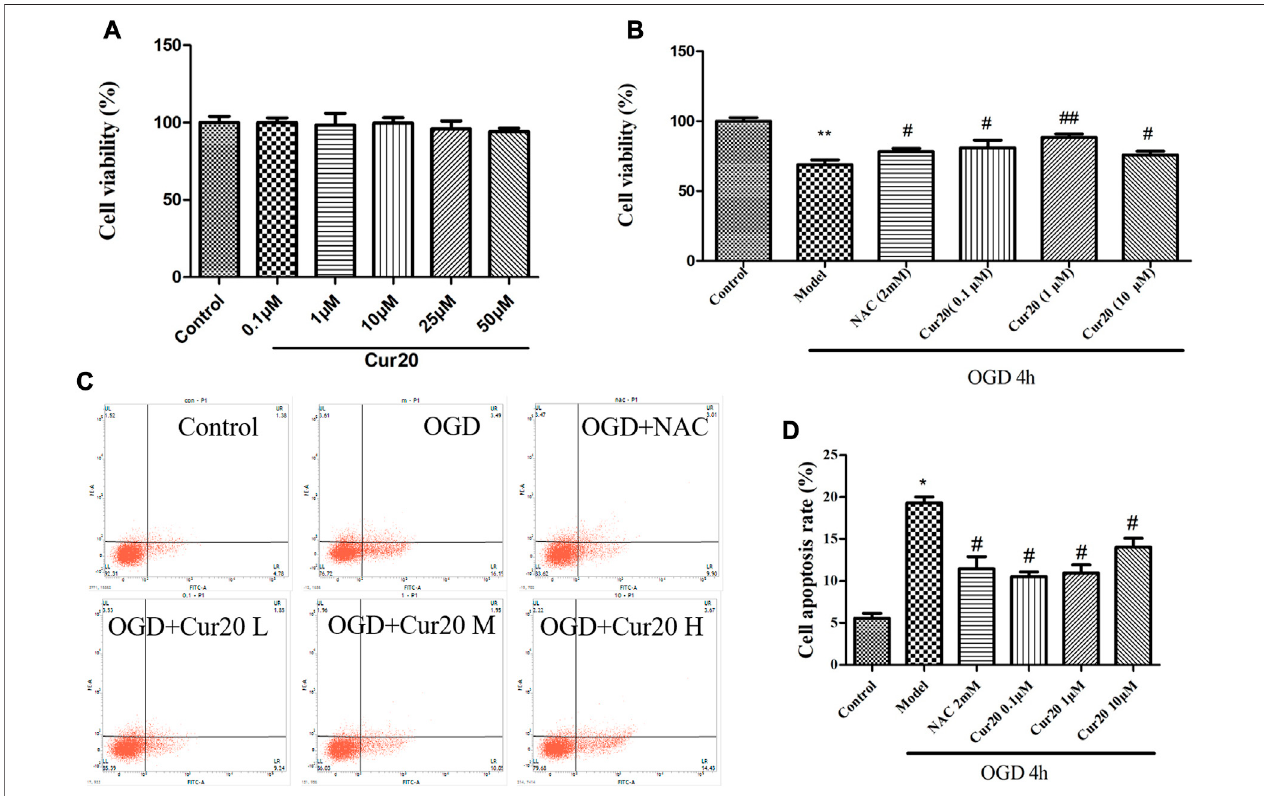
FIGURE7| Cur20showedprotectiveeffectonOGD-treatedrBMECswithoutcytotoxicity. A ,Cur20treatmentperseshowednocytotoxicityonrBMECs. B ,Cur20 reversed OGD-induced cell damage by MTT assay. C – D , Flow Cytometry assay was utilized for cell apoptosis test. L, M, or H represents the concentration of Cur20 as 0.1, 1, 10 μ M, respectively. The experimental data was expressed by mean ± SD, n (cid:2) 3.* p < 0.05 vs. control group, ** p < 0.01 vs. control group, # p < 0.05 vs. Model group, ## p < 0.01 vs. Model group.